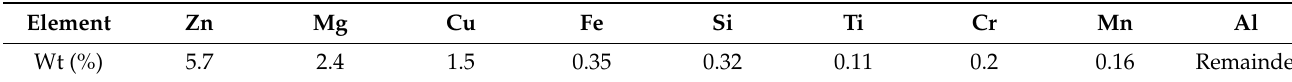
Table 1. AA 7075-T651 chemical composition.